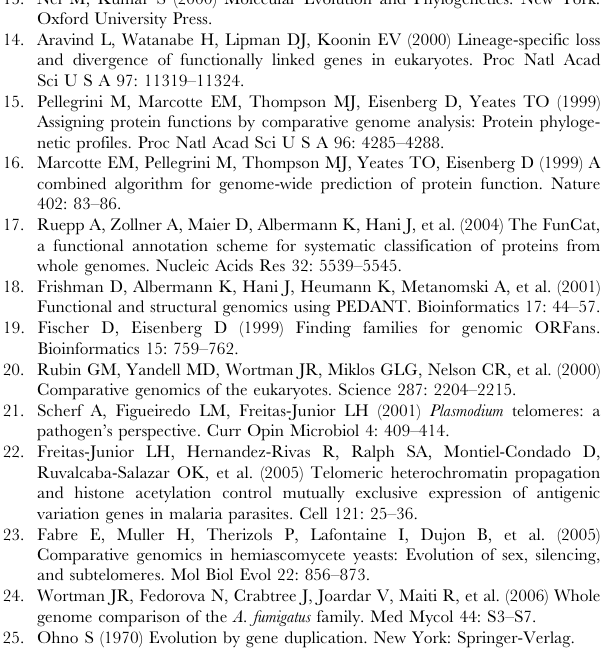
Table S2 Enrichment analysis of FunCat categories in LS groups. For each FunCat category, a statistical significance according to Fisher’s exact test is indicated if multiple hypotheses corrected p , 0.05.